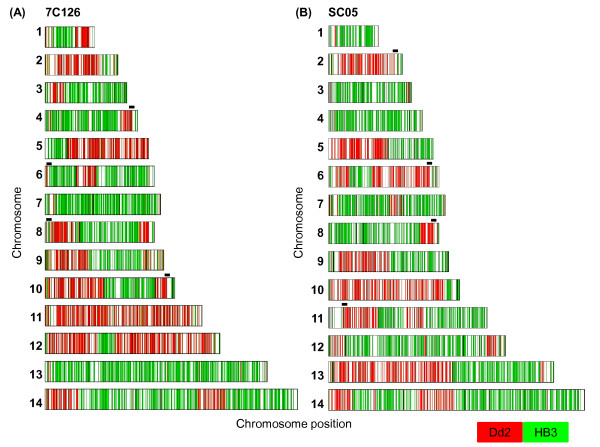
Genome wide distribution of crossovers in progeny strain 7C126 and SC05. Genome wide distribution of COs in (A) 7C126 and (B) SC05. Chromosomes 1-14 are lined up from top to bottom. Each line within a chromosome represents a single SNP marker. HB3 alleles are shown in green bars and Dd2 alleles are shown in red. 23 and 20 COs and putative gene conversion events were detected for 7C126 and SC05 respectively in the current MS marker based linkage map [25]. In contrast, the 454 SNP marker map detected 27 and 24 COs for 7C126 and SC05 respectively. The 454 SNP marker map was successful in the discovery of previously unknown CO events (highlighted with black bars). Refined views of the previously unknown COs are depicted in Additional file 3.